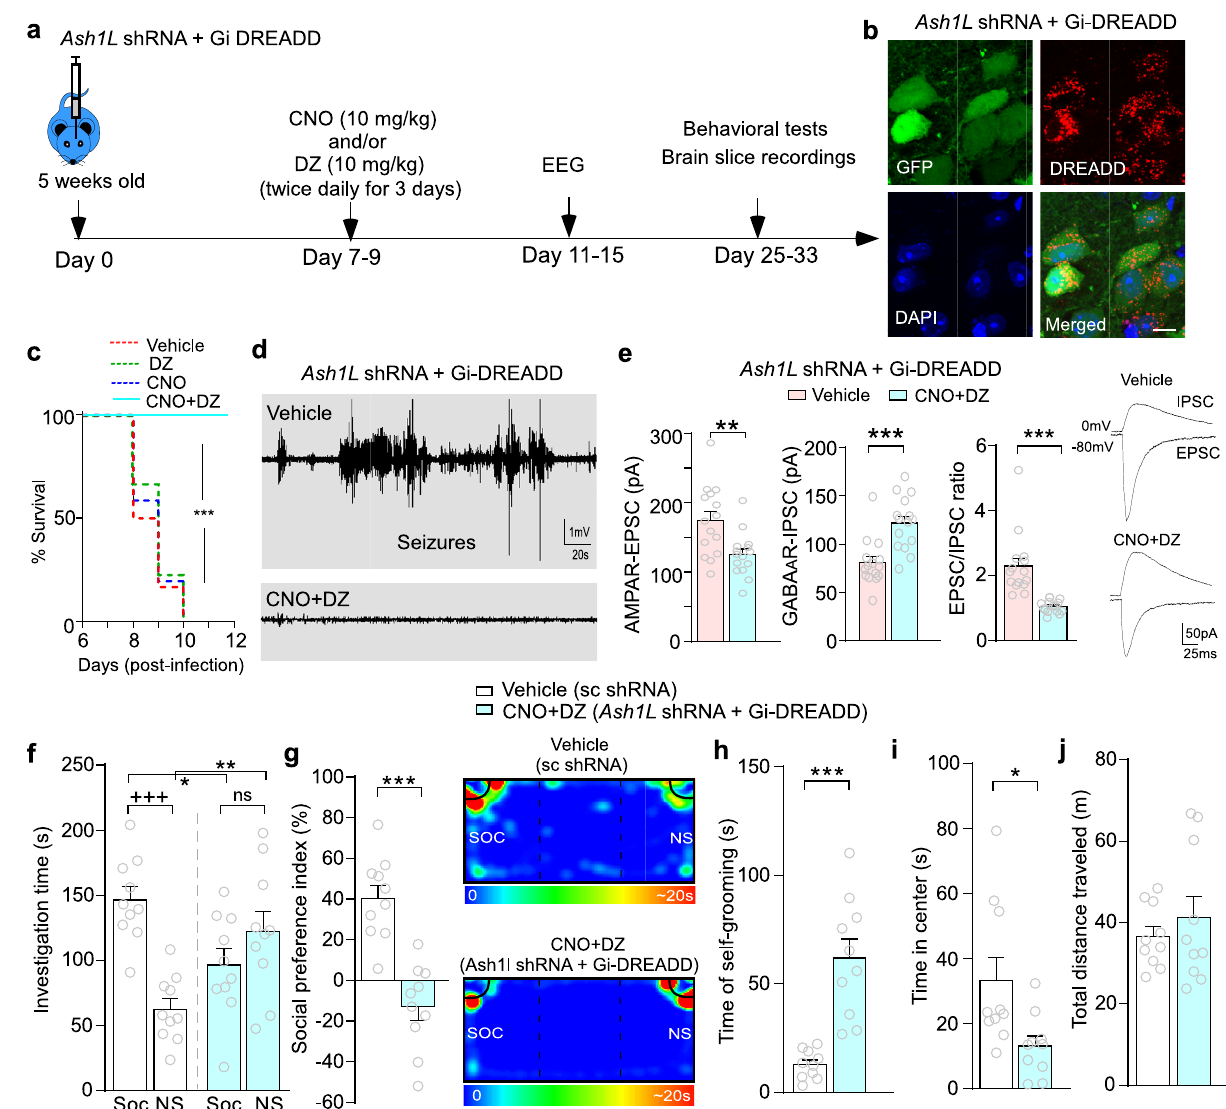
Fig. 6 Combined chemogenetic and pharmacological treatment of Ash1L -de fi cient mice ameliorates seizures, but not other ASD-related behavioral de fi cits. a A schematic diagram of the timeline for treatment and experimental measurements. b Confocal images showing CaMKII-driven Gi-DREADD (red) expression in Ash1L shRNA (Green)-infected PFC pyramidal neurons. Scale bar: 10 μ m. c Survival curves showing the mortality rates of Ash1L- de fi cient mice (w/Gi-DREADD) treated with vehicle or CNO + diazepam (DZ). d Representative EEG traces from Ash1L- de fi cient mice treated with vehicle, DZ alone, CNO alone, or CNO + DZ. n = 12 mice(6 M,6 F)/group, *** p < 0.001, Mantel-Cox test. e Bar graphs showing EPSC, IPSC, and EPSC/IPSC ratio recorded in PFC pyramidal neurons from Ash1L- de fi cient mice treated with vehicle or CNO + DZ. n = 15 cells/4 mice (2 M,2 F)/group, ** p < 0.01, *** p < 0.001, two-tailed t test. f , g Bar graphs showing the amount of time spent on interacting with the social (Soc) vs. nonsocial (NS) stimulus ( f ) and social preference index ( g ) in 3-chamber social preference tests of Ash1L- de fi cient mice (w/Gi-DREADD) treated with CNO + DZ vs. control mice (infected with scrambled shRNA) treated with vehicle. n = 10 mice(5 M,5 F)/group, f, * p < 0.05, ** p < 0.01, +++ p < 0.001 (Soc vs. NS), two-way ANOVA; g , t 18 = 5.75, *** p < 0.001, two-tailed t test. Inset: representative heatmaps illustrating the time spent in different locations of the 3 chambers (color scale, blue: 0 sec; red: ~20 sec). h – j Bar graphs showing the time spent in self-grooming ( h ), the time in center of open fi eld tests (i), and the distance traveled in locomotion tests ( j ) of Ash1L- de fi cient mice treated with CNO + DZ vs. control mice treated with vehicle. n = 10 mice (5 M,5 F)/group, h , t 18 = 5.48, *** p < 0.001; i , t 18 = 2.6, * p < 0.05, two-tailed t test. Data are presented as mean values ± SEM. Detailed statistical data are provided in a Source Data fi genes by conferring a relaxed chromatin structure via H3K4 and H3K36 methylation 10,13,45 . Ash1L epigenetically affects the expression of osteogenic and chondrogenic transcription factors via modifying the enrichment of H3K4me3 on their promoter regions 46 . However, the role of Ash1L in regulating neuronal genes is largely unknown. Here we have found the signi fi cantly decreased expression of ASH1L and H3K4me3 in postmortem PFC tissues from idiopathic ASD patients, which may contribute to the alteration of H3K4me3 landscapes in PFC of ASD patients 47 .